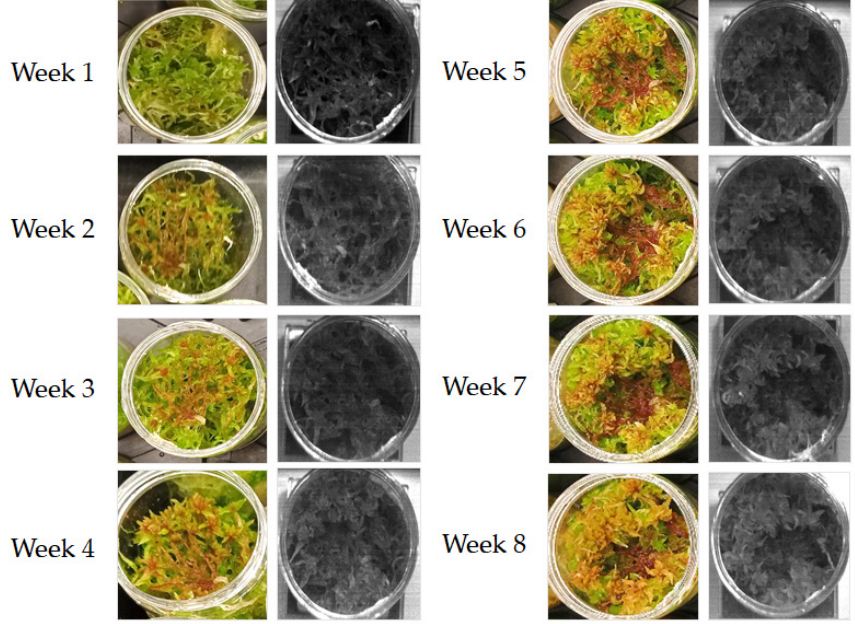
Figure 11. Visual change to redder pigmentation observed in all groups as a result of a change to colder conditions shown alongside hyperspectral image frames taken from red wavelengths, clearly demonstrating the observed change. Example taken from a control group